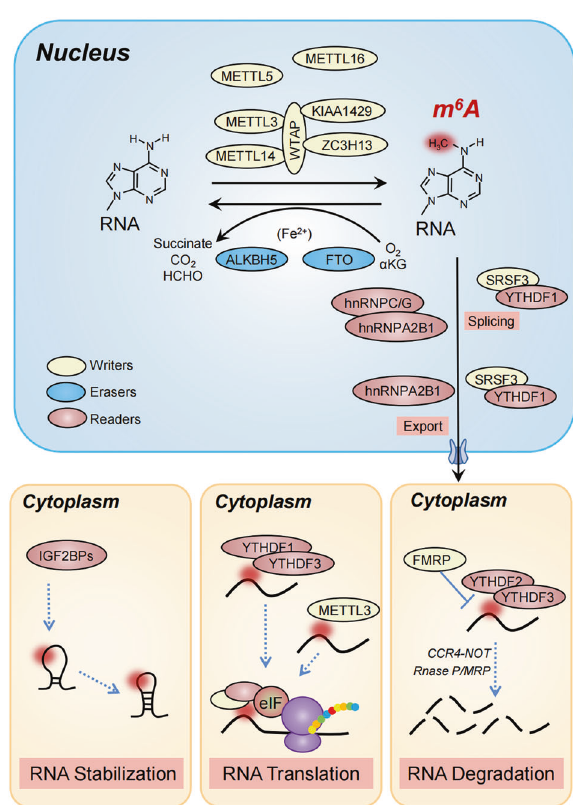
Fig. 1 The writers, erasers and readers in the reversible m 6 A modi fi cation. m 6 A RNA modi fi cations are catalyzed by the multi- component methyltransferases complex (MTC), including the core factors composed by METTL3, METTL14, and WTAP and additional co-factors such as METLL5 and METLL16. FTO and ALKBH5 trigger the removal process by recruiting ferrous iron as a co-factor and α - ketoglutarate as a co-substrate. m 6 A modi fi ed RNAs are recognized by reader proteins such as hnRNPs to facilitate splicing and nuclear export of mRNAs. Cytoplastic m 6 A modi fi ed RNAs identi fi ed by IGF2BPs and YTH domain containing proteins contribute to stabilization, enhanced translation, and degradation in reader- dependent